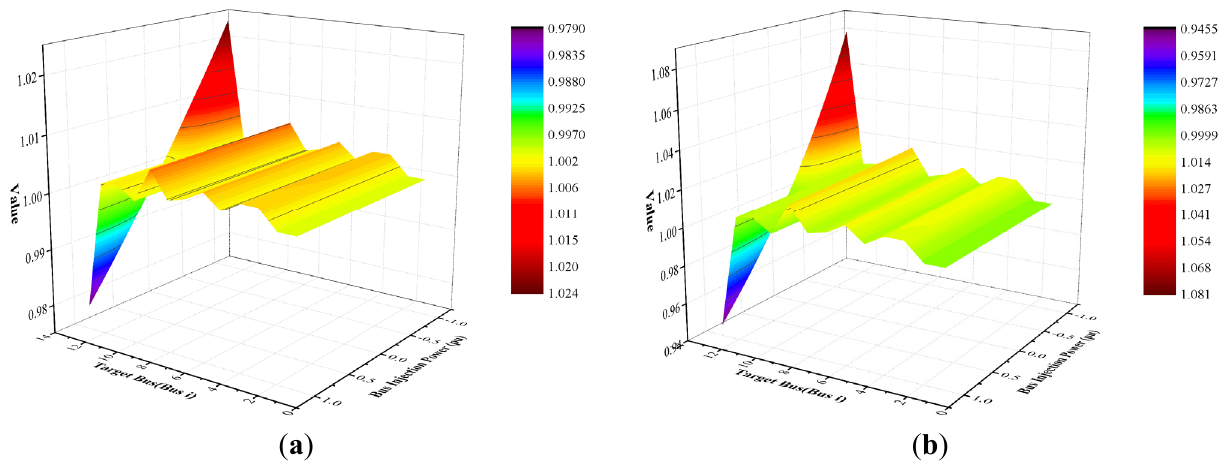
Figure 5. The results of Equation (36) as a function of the injected power at the bus. ( a ) V slack = 1.0 pu; ( b ) V slack = 0.6